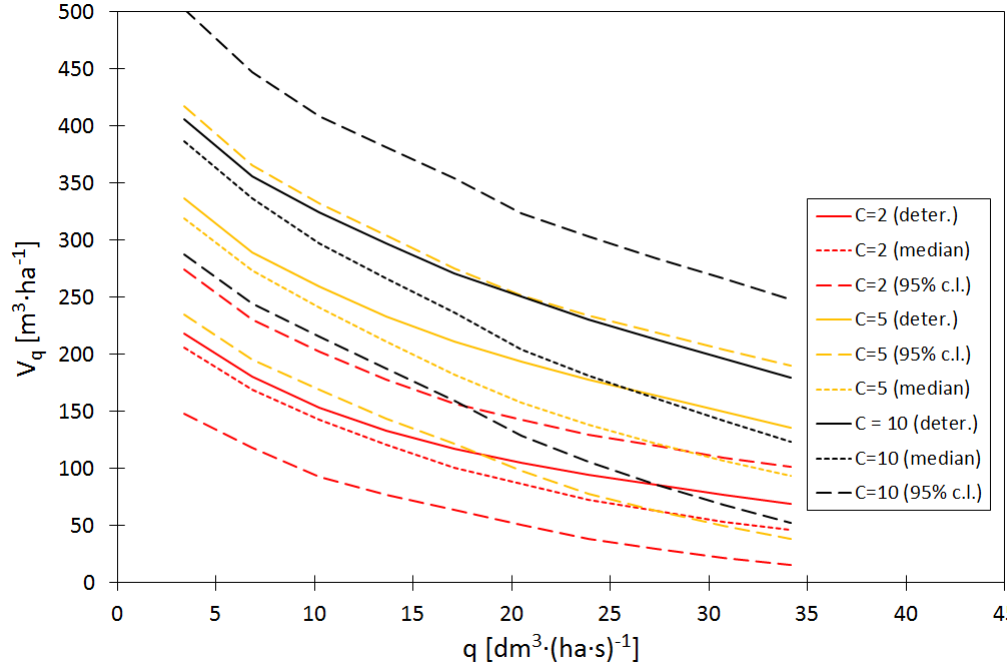
Figure 8. Influence of the unit outflow from the reservoir (q) and the rainfall frequency (C) on the unit accumulation capacity ( V q ), taking into account the model uncertainty (where: c.l.—confidence level)